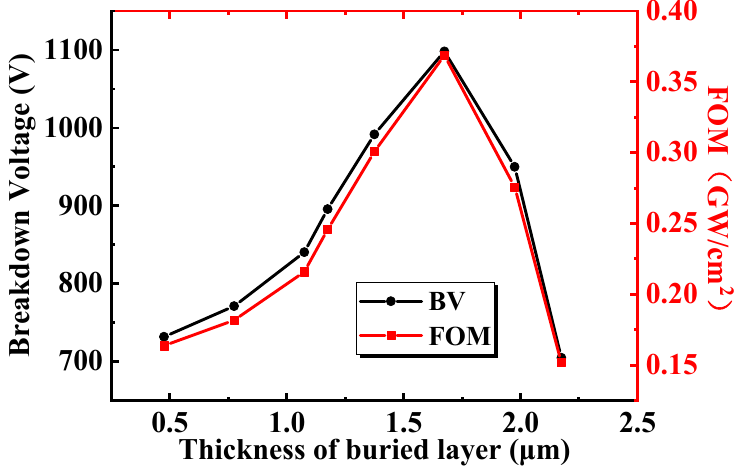
Figure 8. The influence of the thickness of the buried layer on the breakdown voltage and the FOM of the proposed BP HEMT.